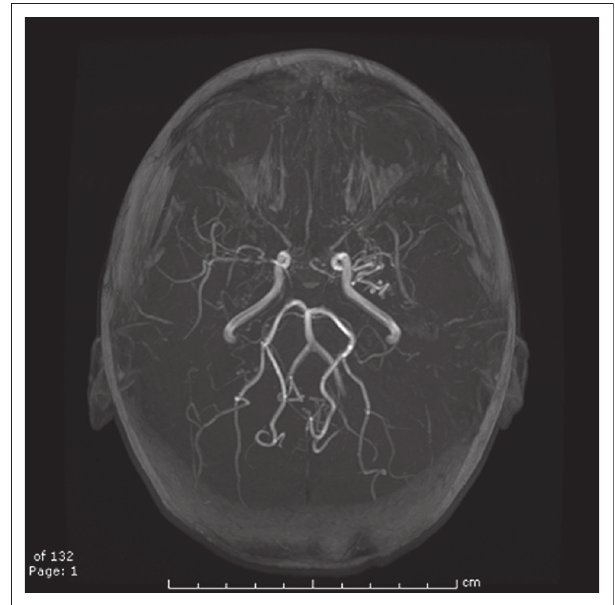
MR, magnetic resonance. FIGURE 3: MR angiography demonstrating moyamoya disease, with stenosis of the distal aspect of the internal carotid arteries, the proximal aspects of the middle cerebral arteries and the anterior cerebral arteries, with subsequent collateral vessel formation resembling a puff or spiral of smoke, which describes the cloud-like lenticulostriate and thalamostriate